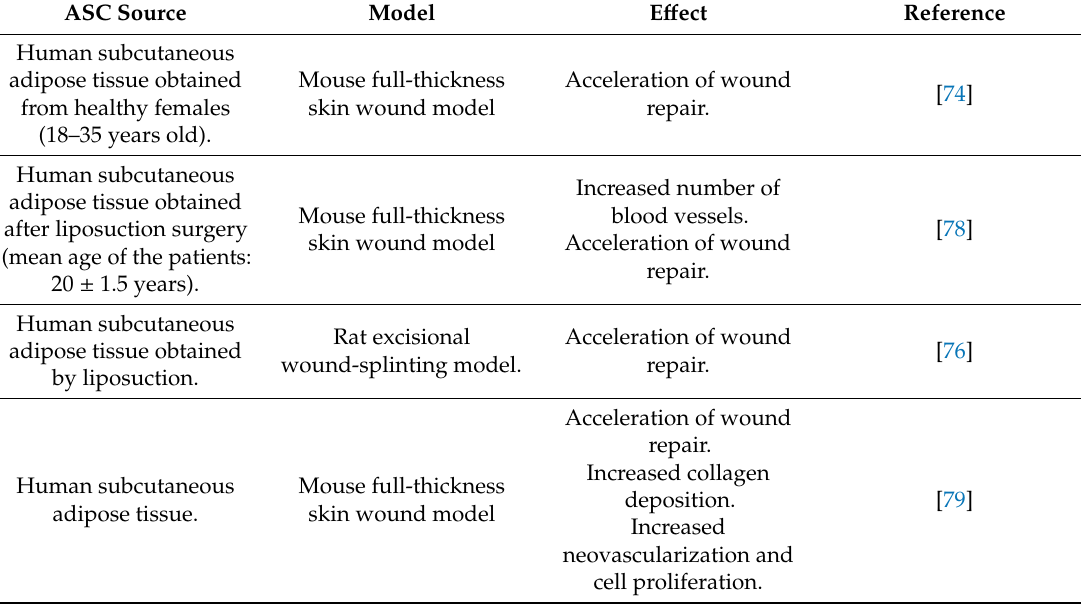
Table 4. E ff ects of ASC-secreted Extracellular Vesicles on Wound Healing: In vivo studies. ASC Source